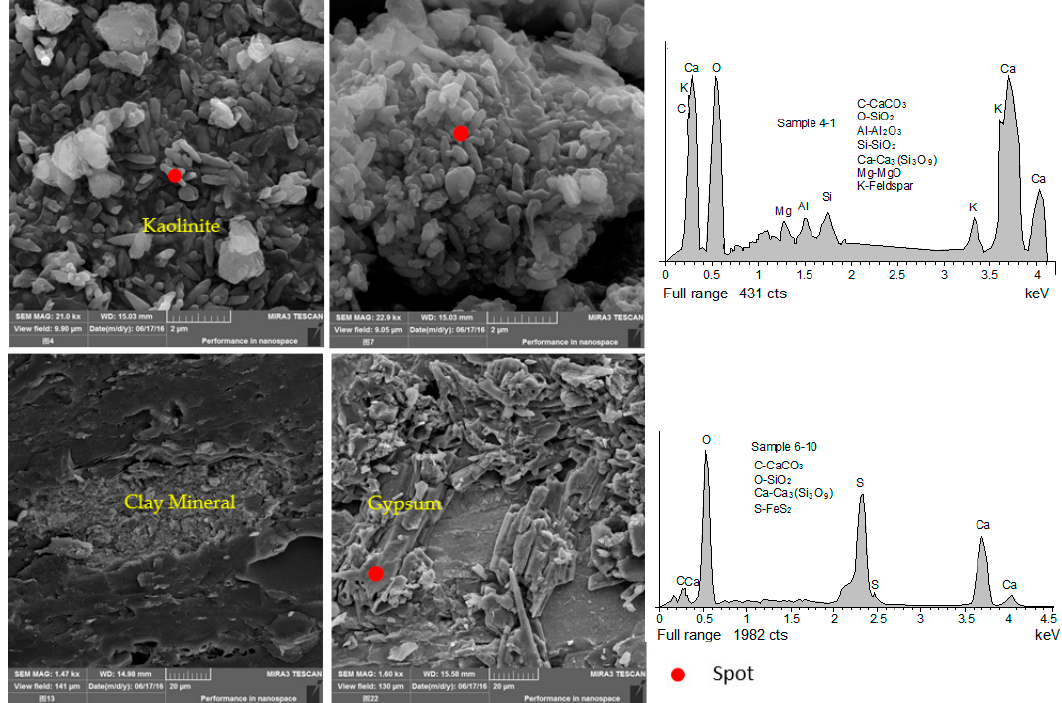
Figure 11. The SEM-EDX analysis for No. 4 and No. 6 coal samples.